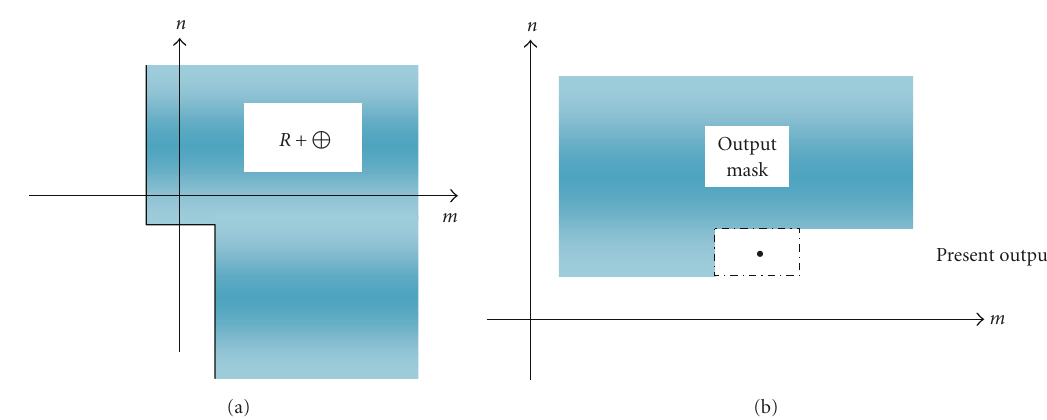
Figure 2: (a) The + ⊕ Nonsymmetric Half-Plane. (b) 2D recursion using a + ⊕